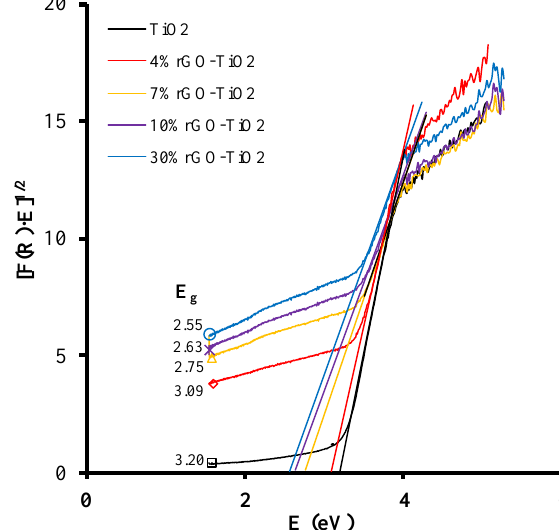
Figure 10. Relationship between transformed Kubelka-Munk function and light energy for TiO 2 and rGO-TiO 2 composites.